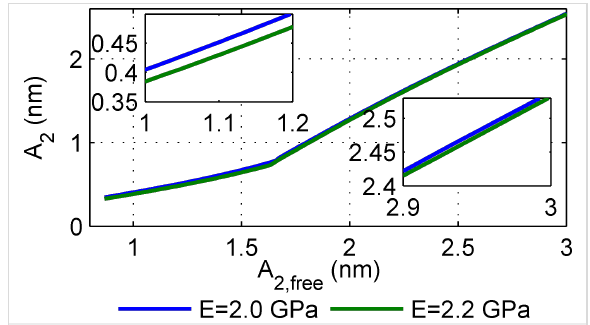
Figure 7: The simulation of Figure 6 repeated except with a pure Hertz model (no energy dissipation). In comparison to Figure 6, there are no sudden jumps and the second eigenmode contrast does not